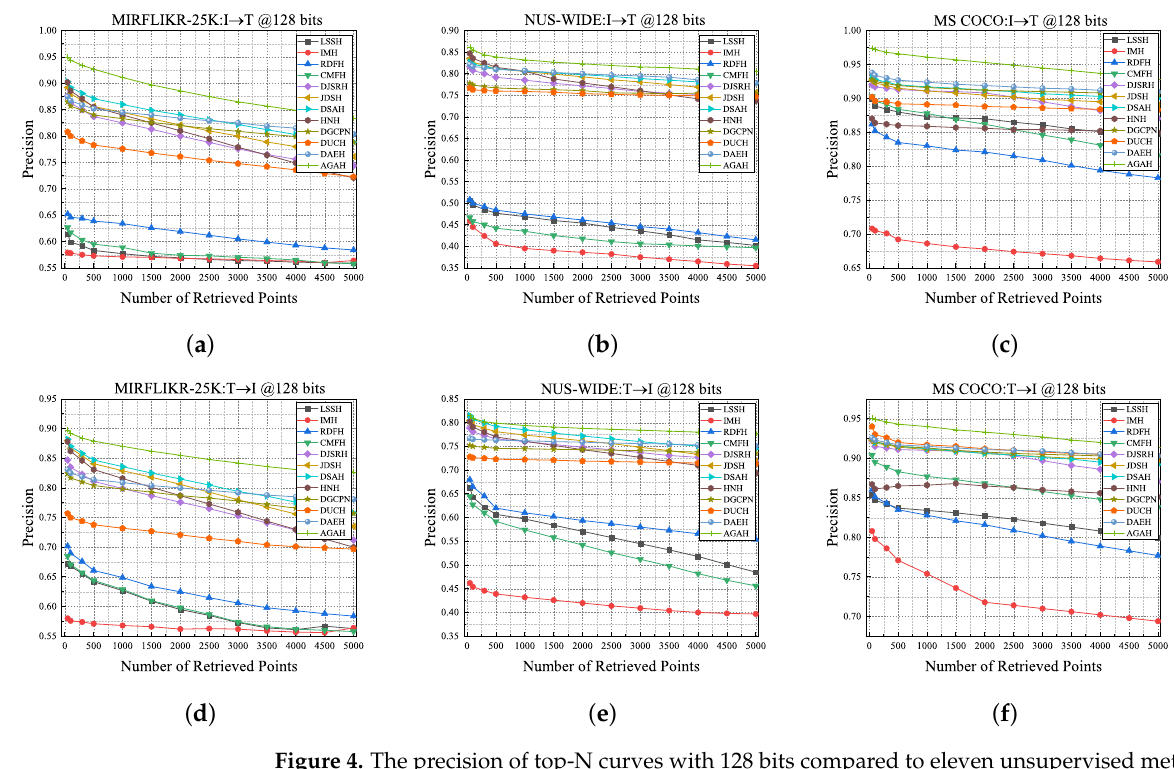
Figure 4. The precision of top-N curves with 128 bits compared to eleven unsupervised methods on three benchmark datasets. (a)(b)(c) show the top-N accuracy curves for image retrieved text ( I → T ) on MIRFLICKR-25K, NUS-WIDE, and MS COCO datasets, respectively. (d)(e)(f) display the top-N accuracy curves for text retrieved image ( T → I ) on the three datasets,